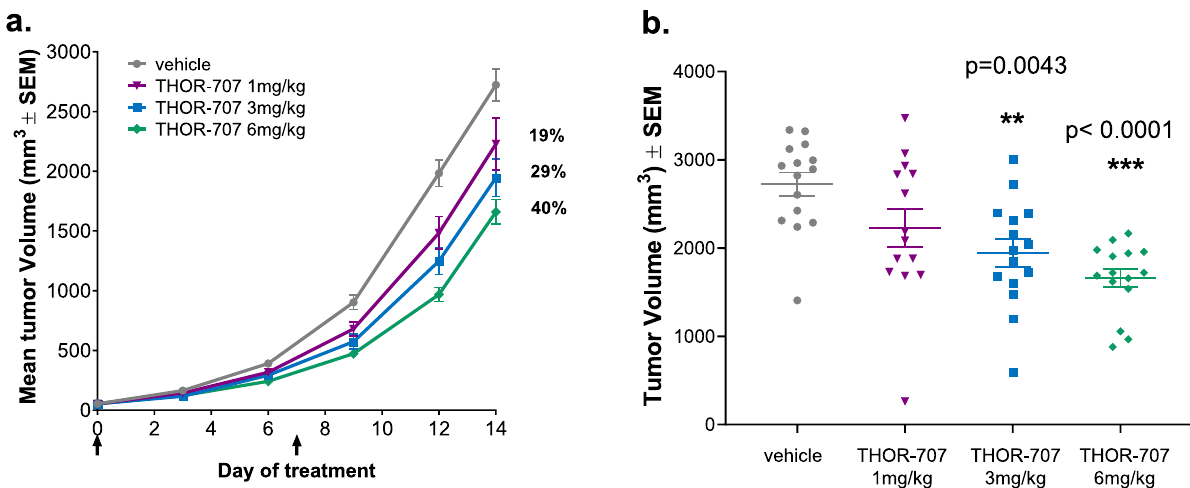
Fig. 6 THOR-707 reduces B16-F10 tumor proliferation in C57BL/6 mice. a Mice implanted with B16-F10 tumors were administered vehicle or THOR-707 doses at 1, 3, and 6 mg/kg upon tumor size measuring 50 mm 3 (day 0) and 1 week later (day 7). Mean tumor size (±SEM) in mm 3 is plotted at 3-days intervals post-dose initiation of treatment, indicated by black arrows, and percentages indicate the percent reduction in mean tumor volume observed at day 14. b Tumor volumes (mm 3 ) measured at day 14 post-dose initiation are plotted for different dose groups. Each point indicates an individual tumor, mean tumor volume (horizontal line with error bars representing ± SEM) is shown. n = 15 animals. ** p = 0.0043, *** p < 0.0001 using one-way ANOVA. Source data are provided as a Source Data fi